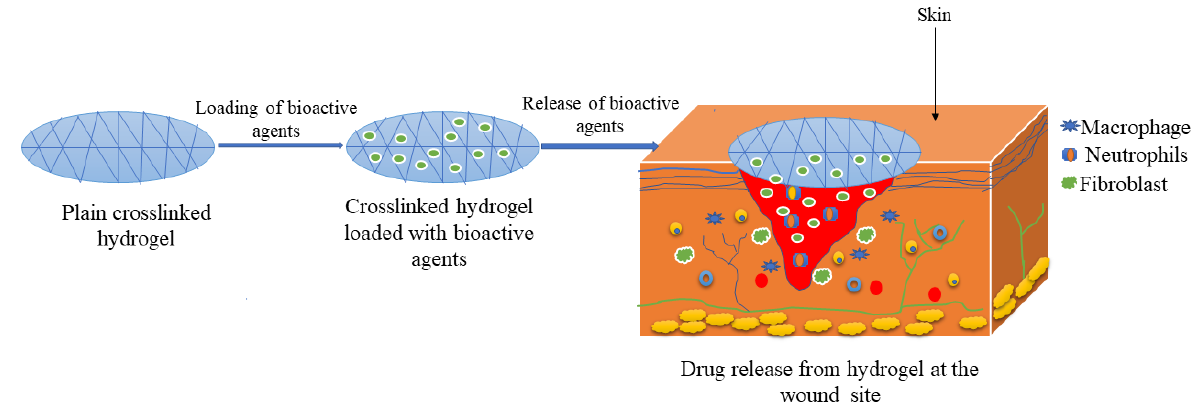
Figure 2. Schematic diagram of hydrogels.